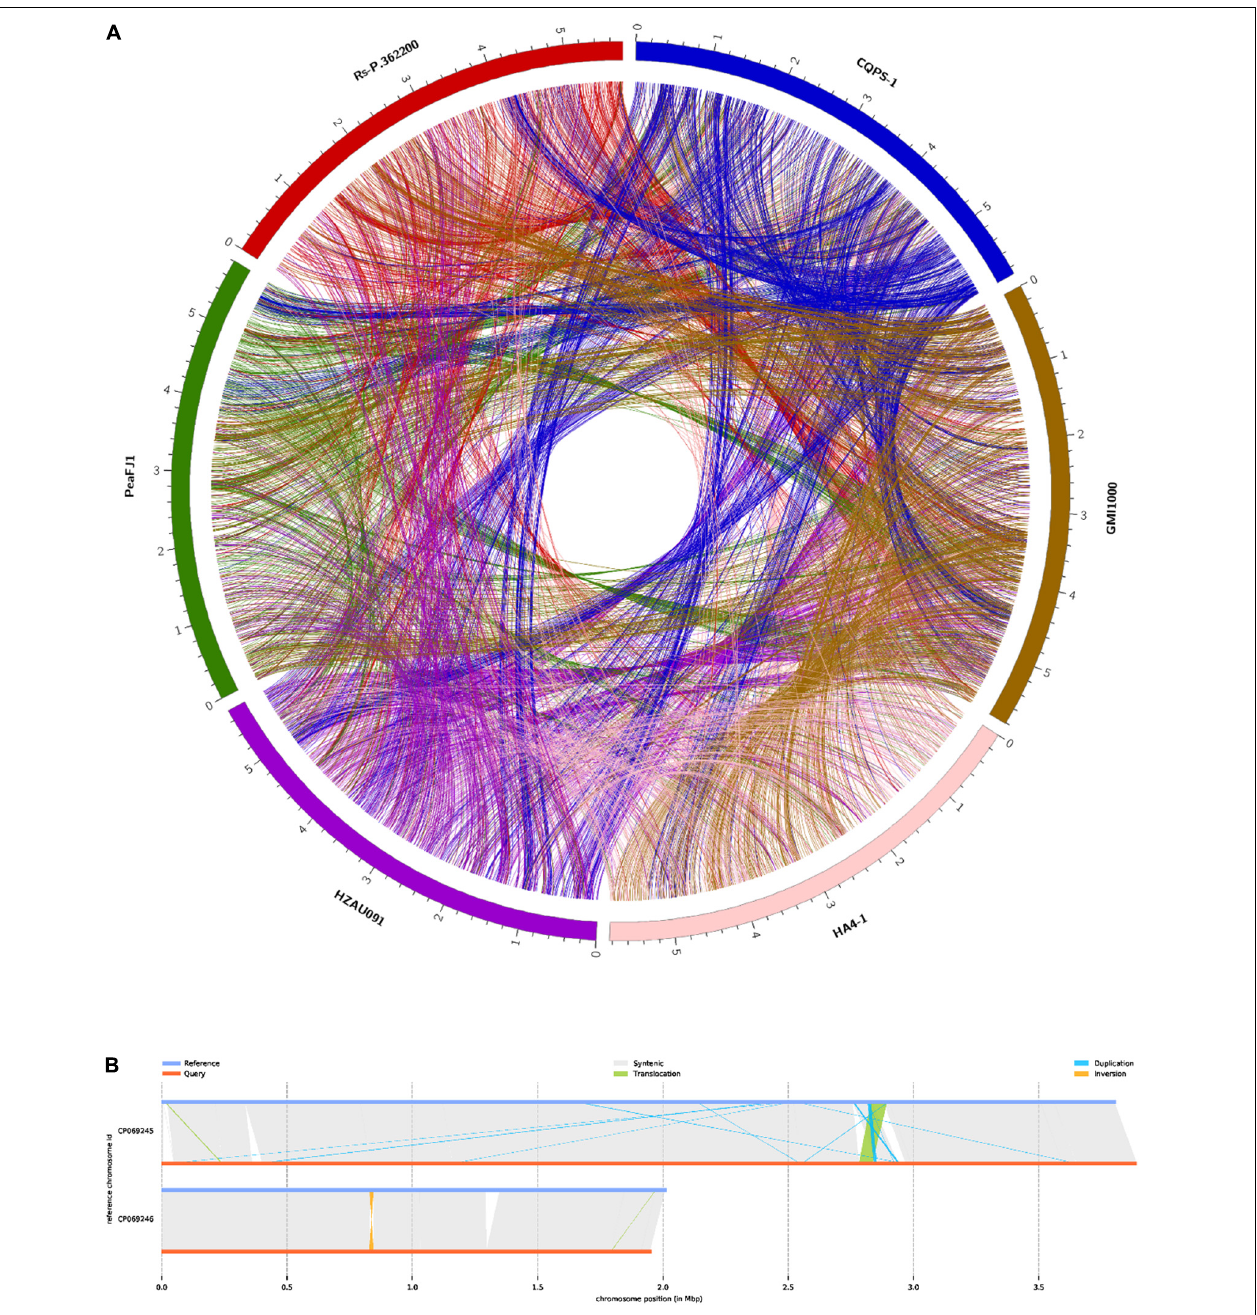
FIGURE 3 | Comparison of R. solanacearum PeaFJ1 with other representative sequenced R. solanacearum strains. (A) Synteny blocks identified in PeaFJ1 across HA4-1, Rs-P.362200, HZAU091, GMI1000, and CQPS-1. (B) Illustration of structural variation types between PeaFJ1 and HA4-1. Reference is HA4-1, and query is